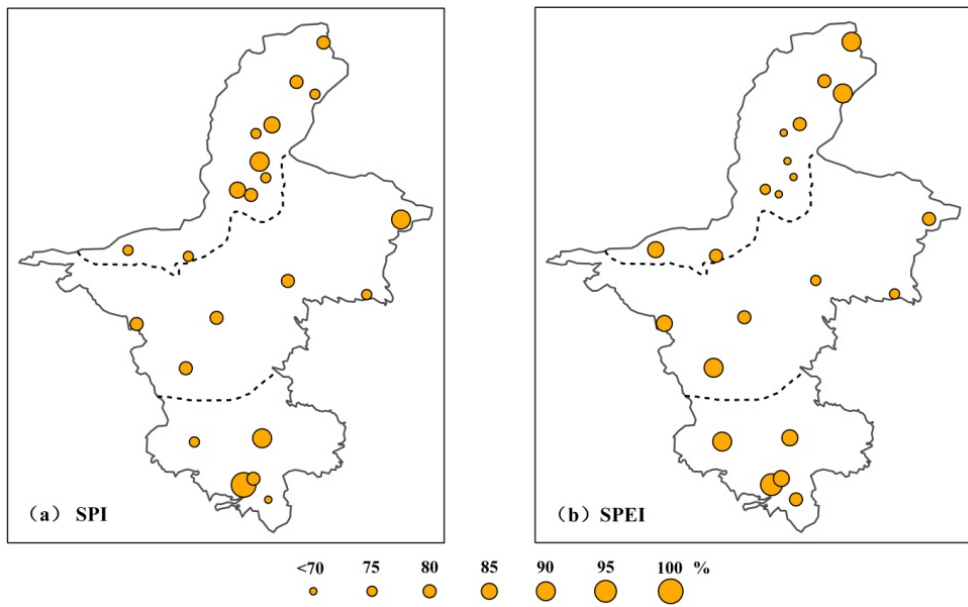
Figure 8. Drought frequency calculated from monthly SPI/SPEI values at the 3-month time scale for 22 stations during the years 1972–2011 in Ningxia. ( a ) SPI, ( b )